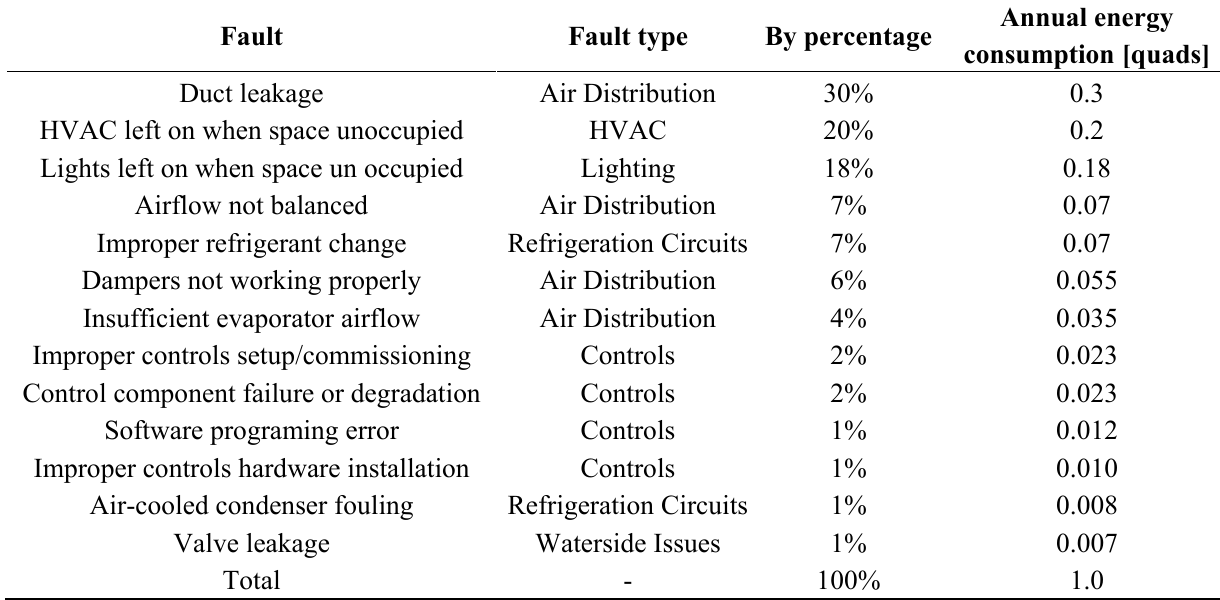
Table 2. The annual energy impact of faults selected for evaluation by Roth et al . [3]